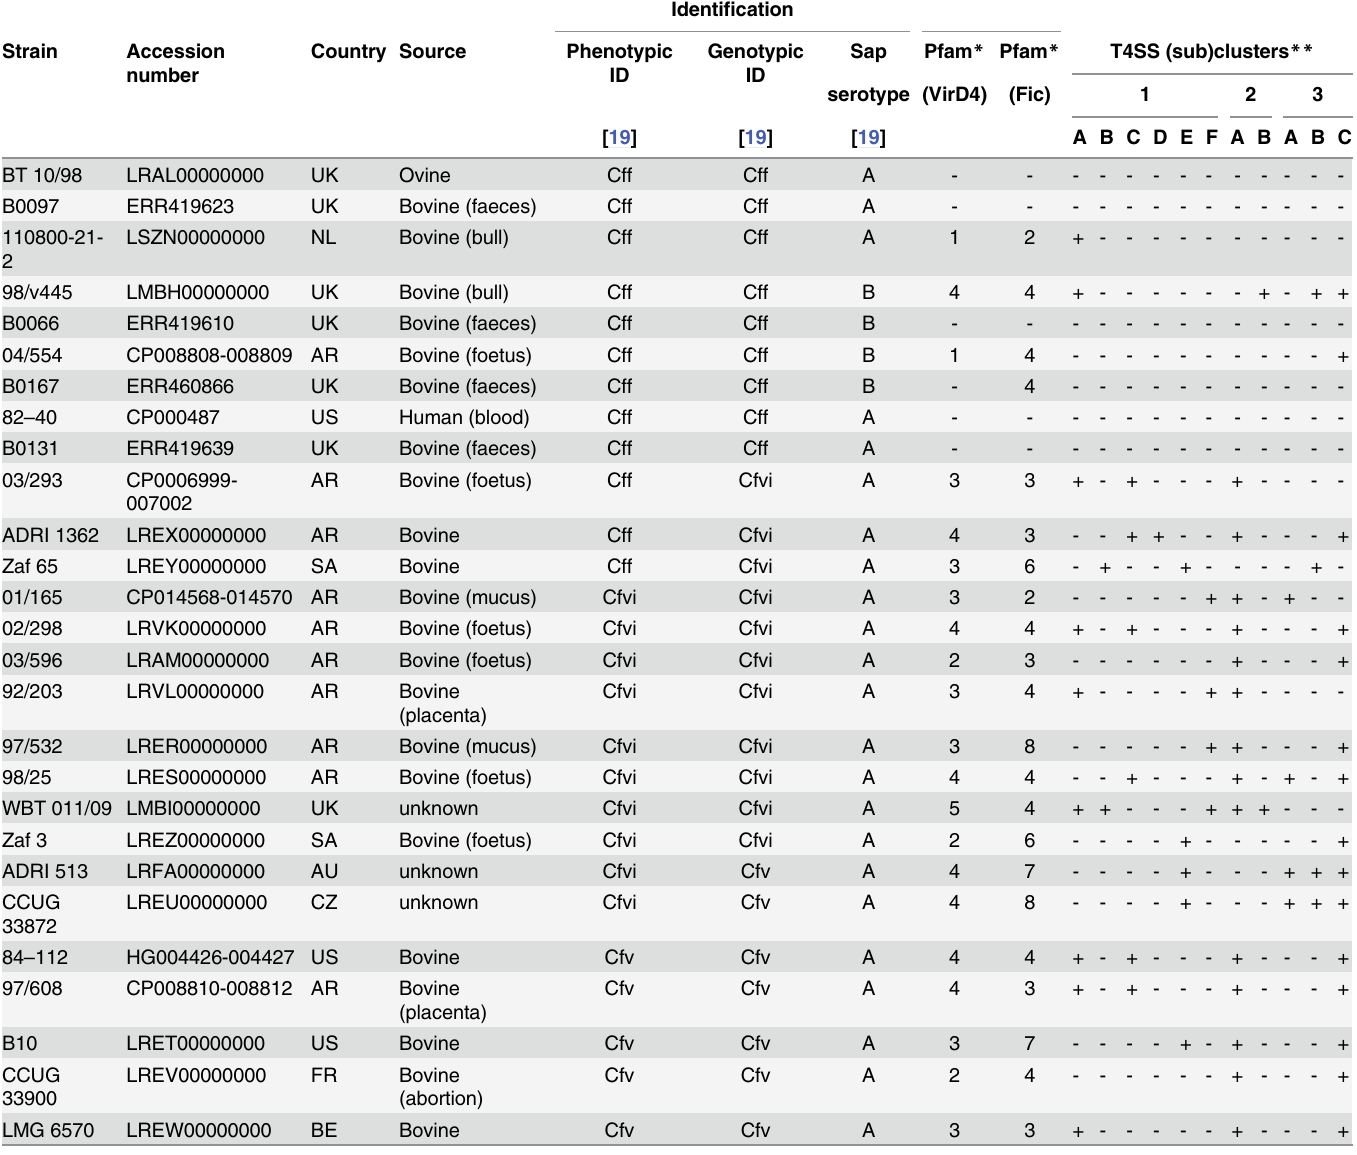
Table 1. Characterization and prevalence of T4SS regions in C . fetus